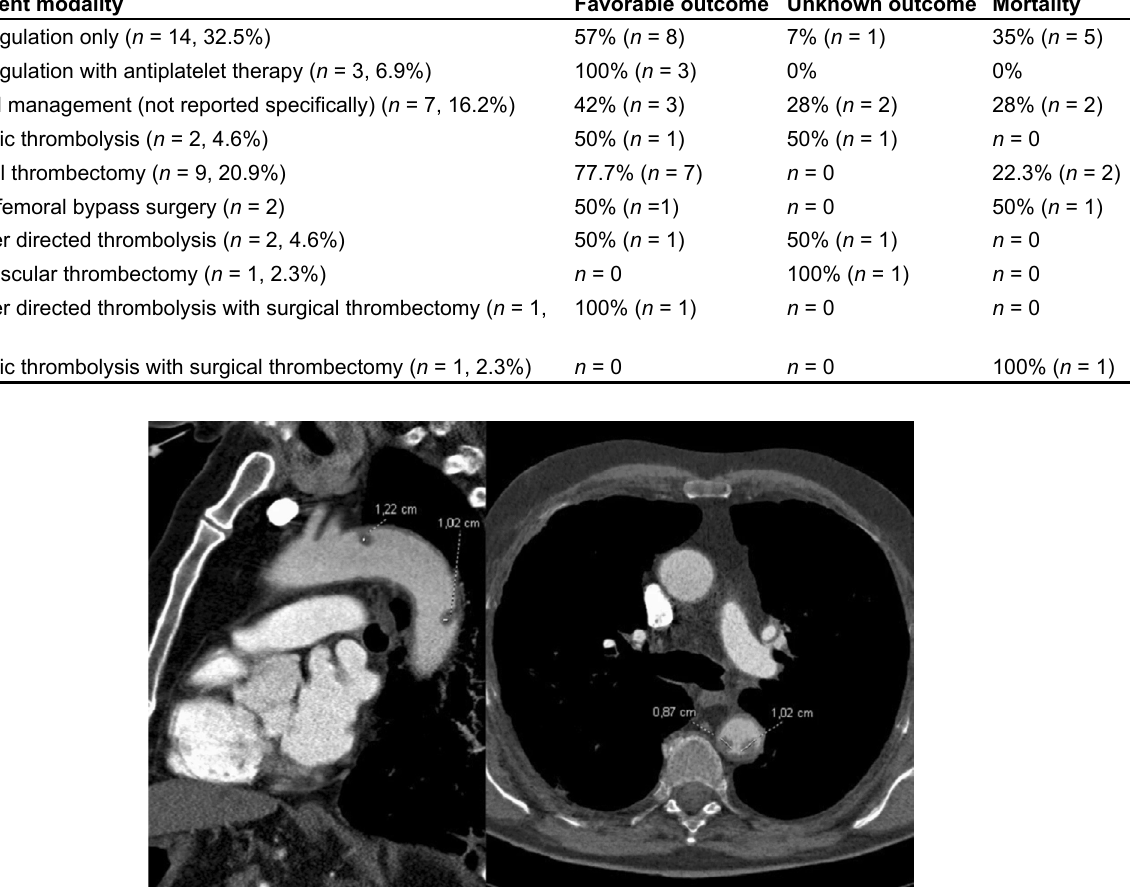
Figure 7. Floating aortic thrombi in a patient with COVID-19 infection